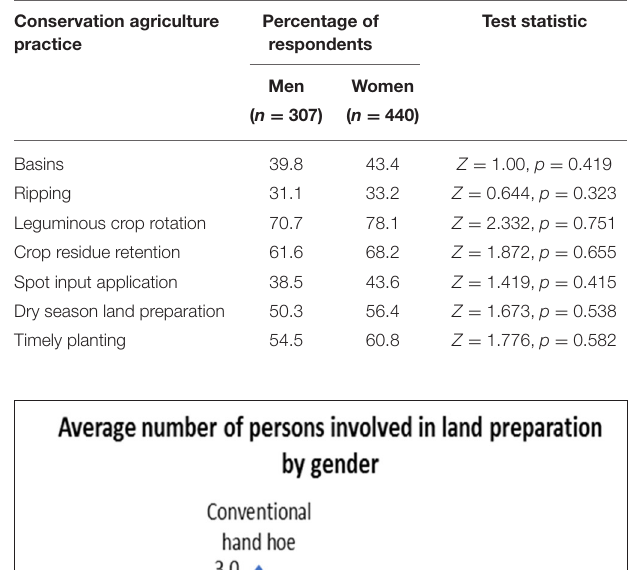
TABLE 2 | Conservation agricultural practices used by men and women in Eastern, Zambia. Conservation agriculture practice